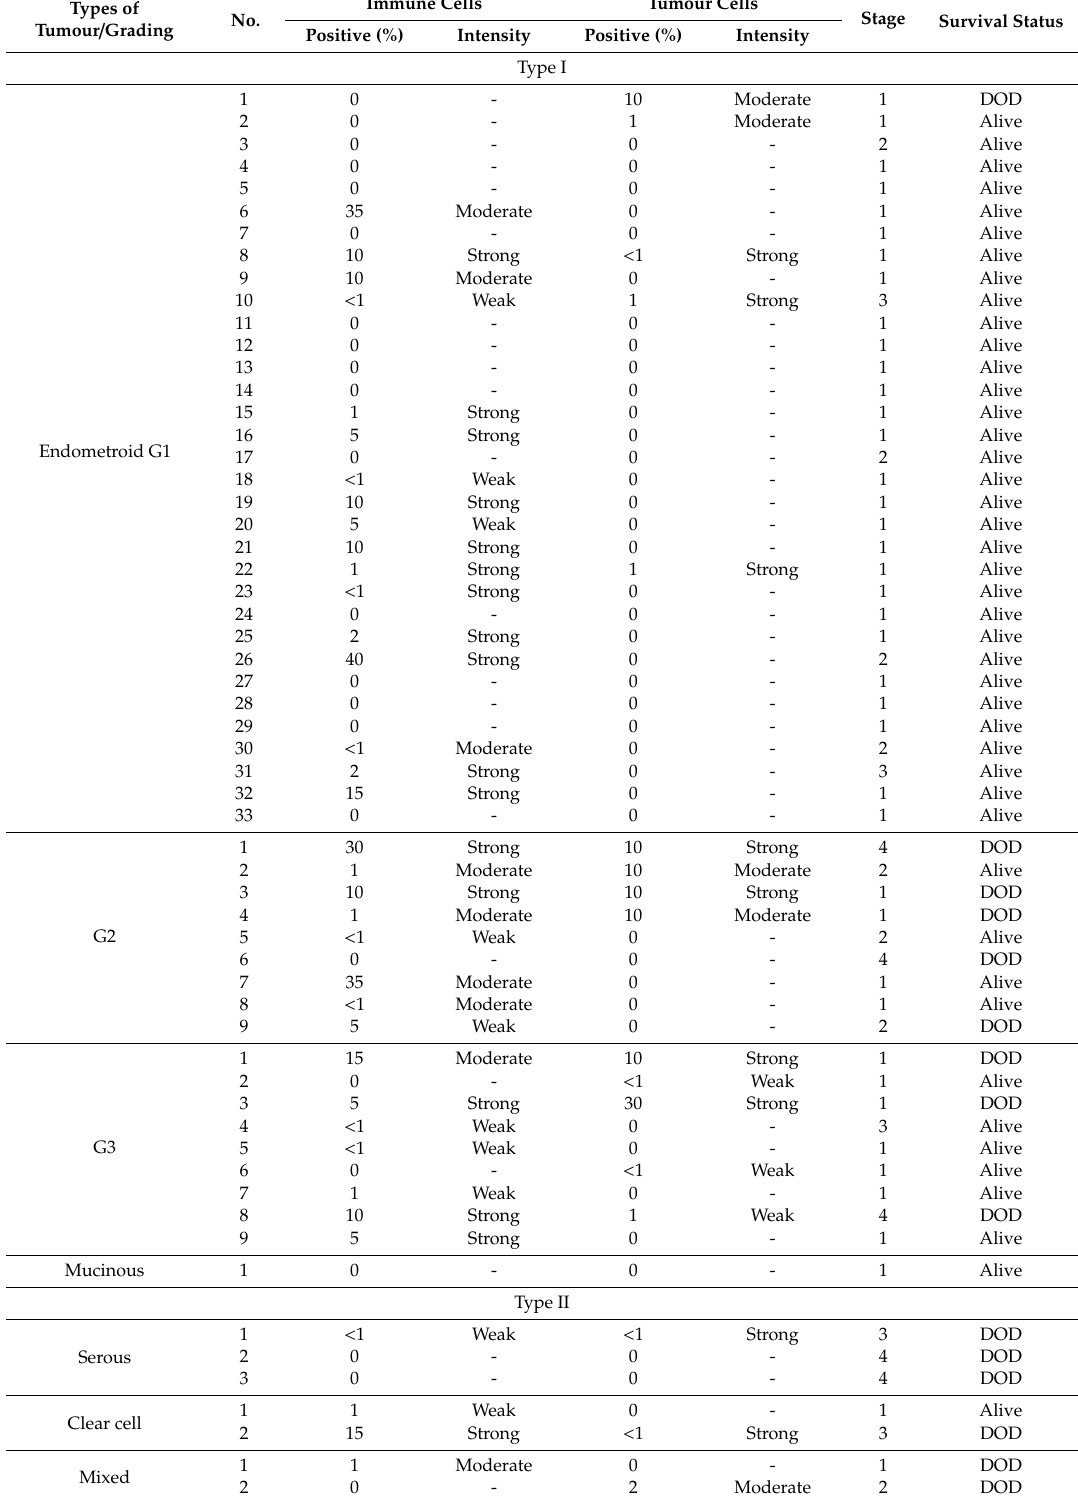
Table 3. PD-L1 staining characteristics in tumour cells and immune cells of endometrial carcinoma. Types of Tumour /